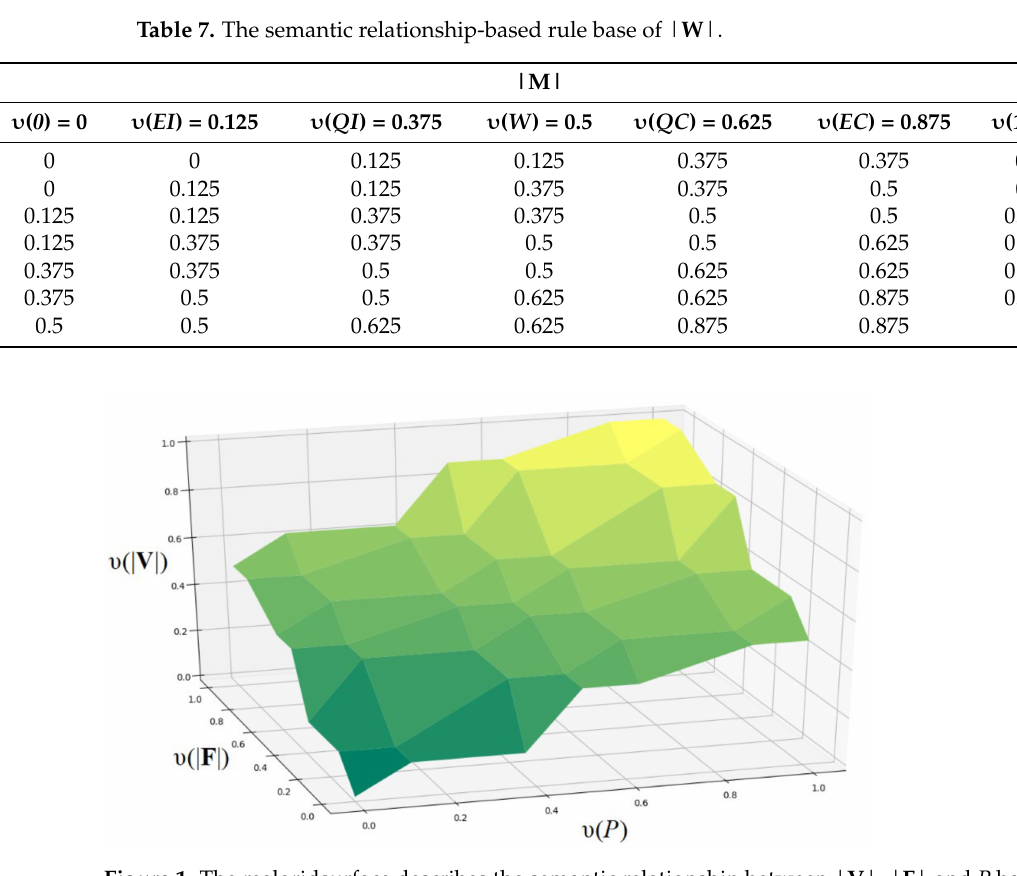
Figure 1. The realgridsurface describes the semantic relationship between | V |, | F | and P based on the four-point bilinear interpolation